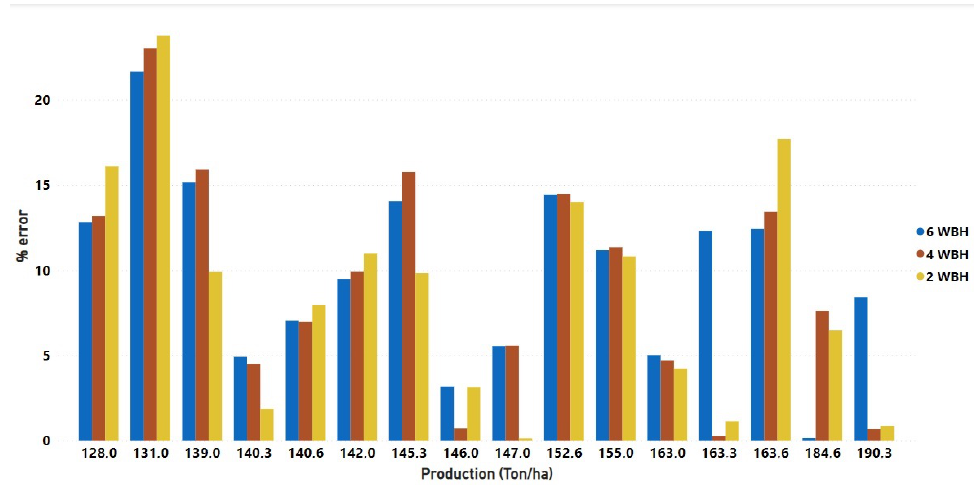
Figure 9. Percentage error in the forecast of tomato yield using the test